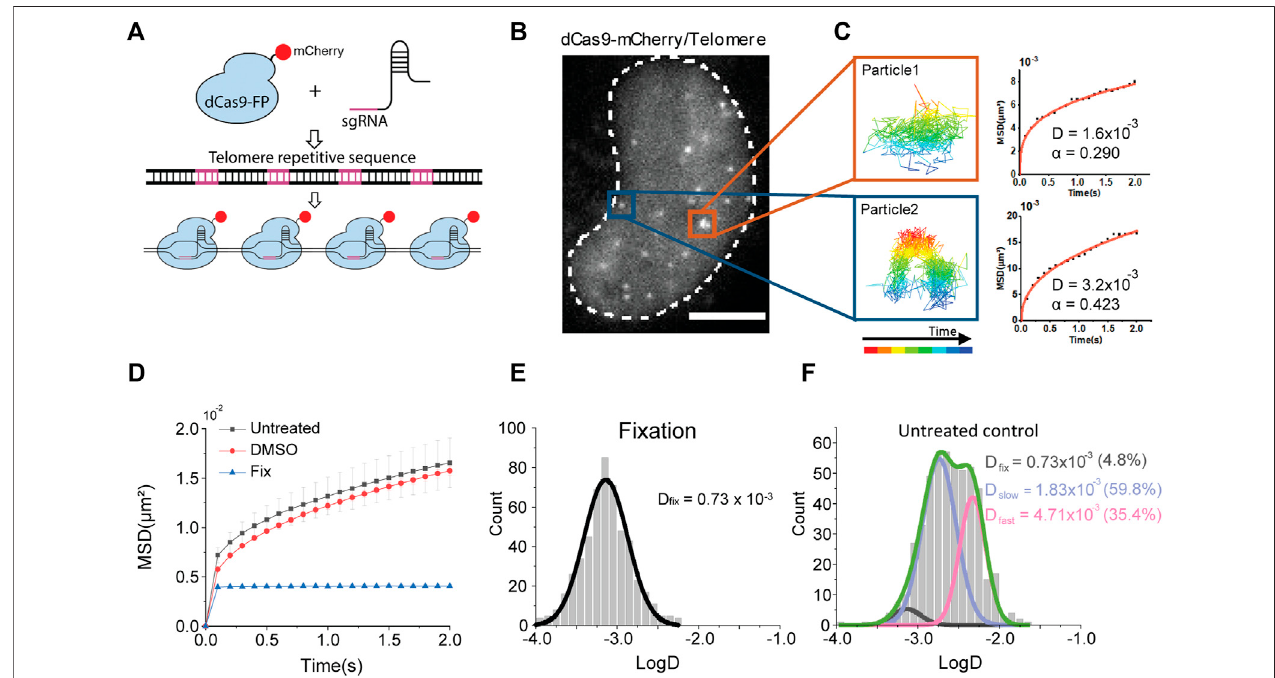
FIGURE 1 | Single chromatin locus tracking and diffusion analysis. (A) A schematic representation of CRISPR/dCas9-labeling on telomere sequences. (B) A representative image of fl uorescently labeled chromatin loci in a living cell nucleus. The scale bar represents 5 μ m. (C) Examples of single locus tracking for diffusion analysis. (D) AveragedMSD-tplotsforeachtimeintervalinlivecellsundernormalculturemedia(N=34cells, n =520trajectories),DMSOtreatment(N=32cells, n =653 trajectories), and fi xed cells (N = 32 cells, n = 575 trajectories). (E,F) Distributions of diffusion constants for individual trajectories in (E) fi xed cells and (F) normally cultured